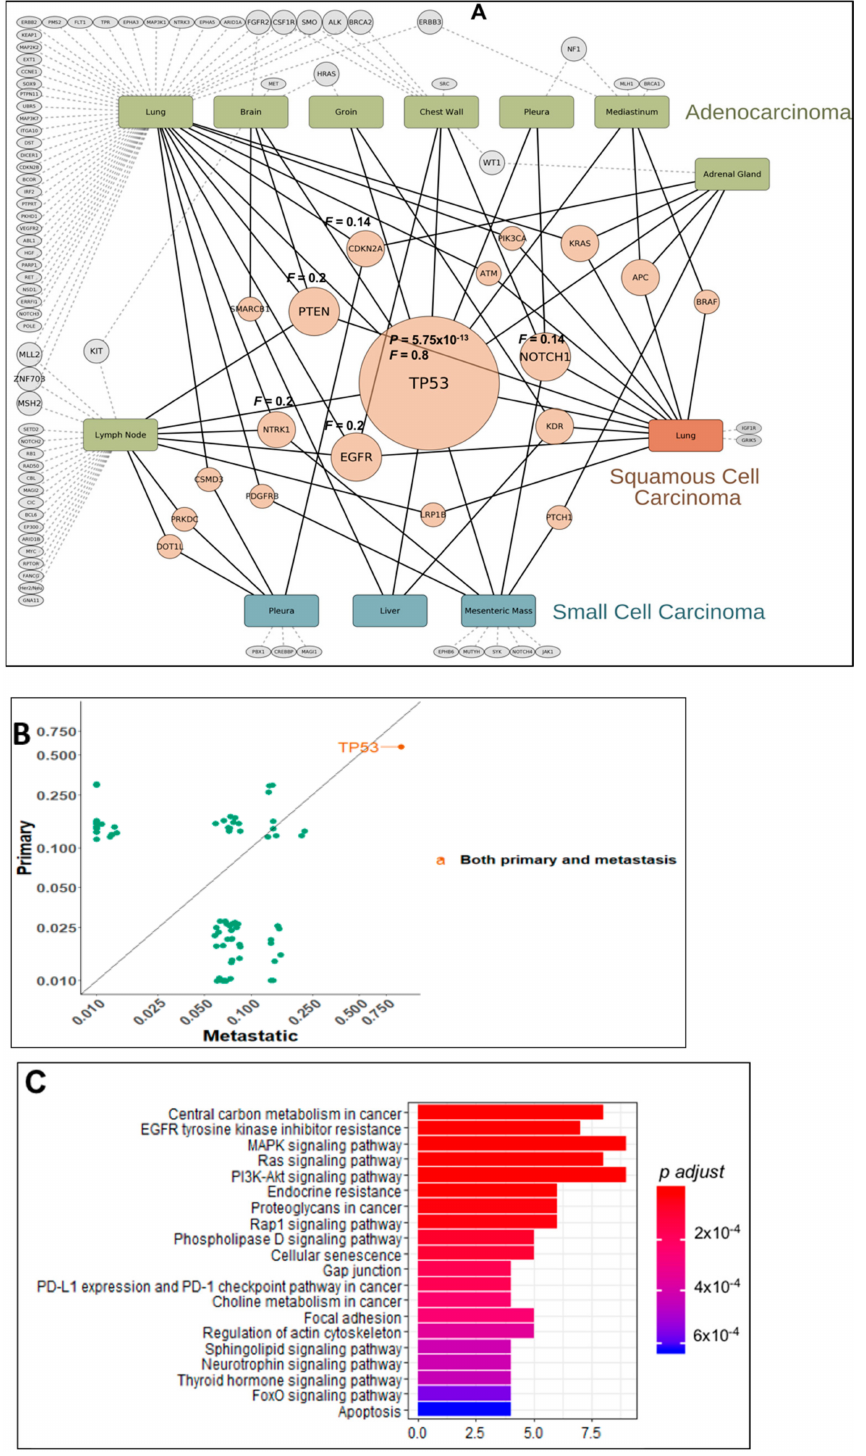
Figure 3. ( A ) Map of mutation frequencies in lung cancer patients. “Gene” node sizes positively correlate with total mutation frequency (F) of the gene among all primary/metastatic sites. Rectan- gular nodes: Primary/metastatic sites colored by histology type. Pink-colored gene nodes: Genes mutated in multiple primary/histology types. Gray-colored genes nodes: Mutated genes unique to a particular site. ( B ) Plot of relative frequency of gene mutations in primary and metastatic and gene enriched are highlighted. ( C ) Signaling pathways altered by significant gene mutation. Genes with significant mutations were analyzed for enrichment of Kegg pathways. Pathways with adjusted p value < 0.05 were selected. The plot shows the significant pathways with bar height as gene